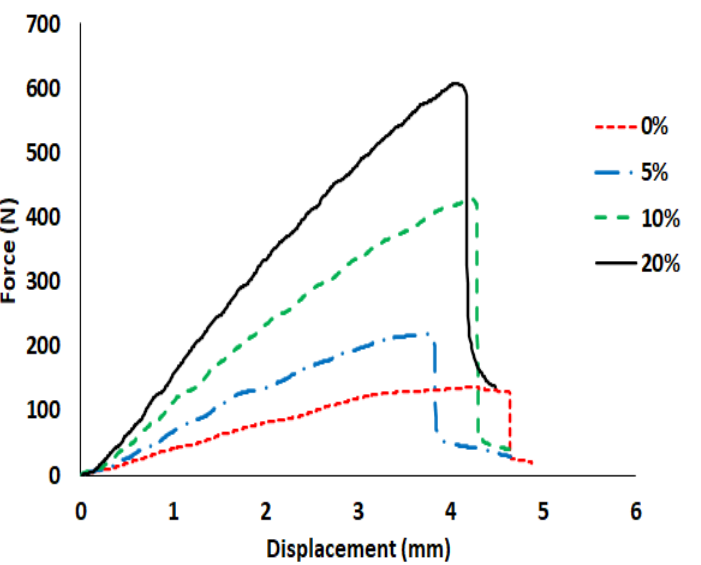
Figure 8. Load-displacement curves of different composites under flexural